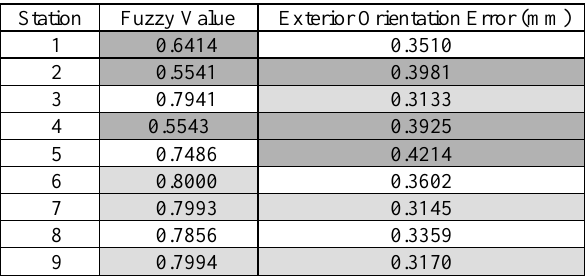
Table 4. Exterior orientation errors and the result of fuzzy value of each station in measuring the car door As Table 4 shows again, the results for the stations that have maximum/minimum exterior orientation standard deviation values are almost the same as the stations that have minimum/maximum fuzzy values. After omission of stations with low fuzzy values, bundle adjustment procedure was done with the rest of images. The result of bundle adjustment before and after omission of inappropriate images is shown in Table 5.